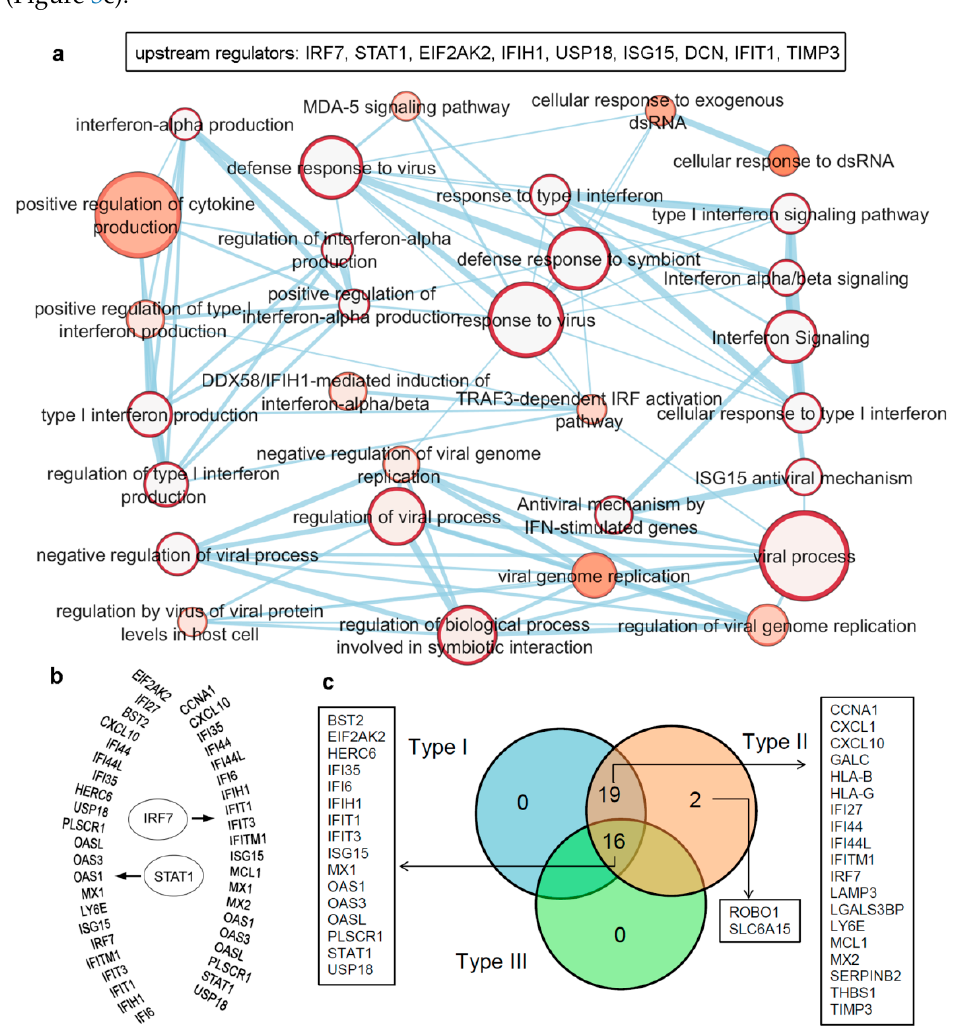
Figure 3. Upstream regulators from the IRDS genes, as well as a list of genes regulated by different IFN types (Type I/II/III). ( a ) IRDS genes (IRF7, STAT1, EIF2AK2, IFIH1, USP18 (ubiquitin specific peptidase 18), ISG15, DCN (decorin), IFIT1 and TIMP3) were found as the upstream regulators in QIAGEN-IPA analysis (Ingenuity Pathway analysis [https://digitalinsights.qiagen.com, accessed on: 07 April 2021]). Genes are presented in ascending order based on the p -values, and the bottom panel represents pathway enrichment analysis for upstream regulators performed using g:Profiler [78,79] and Cytoscape package [80]. The node size corresponds to the number of genes in the da- taset/gene-set size, and colour of the node corresponds to the number of the geneset for the dataset. Edge size corresponds to the number of genes that overlap between two connected genesets. Intra- and interconnecting nodes means some genes are shared in clusters or pathways, and hence, they are represented as edges. ( b ) Different IRDS genes targeted by two major upstream regulators; IRF7 and STAT1. ( c ) Majority of the IRDS genes were found regulated by both IFNs Type I and II or by all three IFN types, whereas only a small amount of genes are regulated by a single type; Type II IFN. The pie chart is generated considering the experimental datasets from the Interferome data- base [81]. Majority of the IRDS genes can be found as the subset of ISGs [81,82], and largely these genes are regulated by both Type I and Type II IFNs or by all three IFN types. Therefore, to identify specific IRDS regulated by a single or multiple type IFNs, we per-